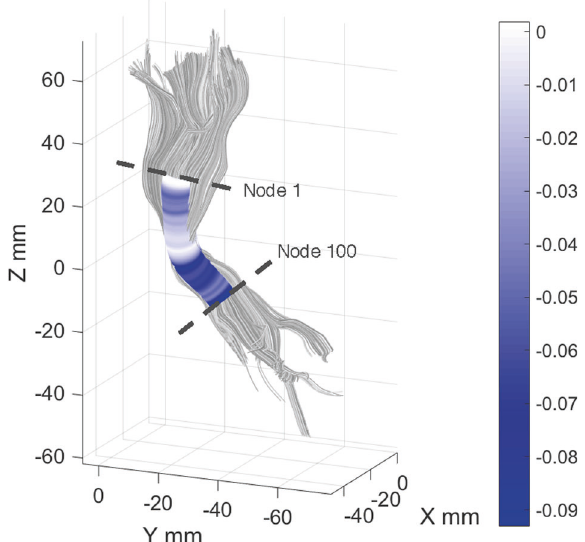
Fig. 5 Correlation of fractional anisotropy (FA) for each segment of the corticospinal tract (gray) with Strengths and Weaknesses Assessment of Normal Behavior Rating Scale for ADHD Hyper- activity Score (SWAN-HY) on clipped regions of interest (blue shaded tube). FA values are regressed out for age, sex, IQ, acquisition site and in-scanner head motion. Strongest correlations were observed at caudal segments of the tract. Node, equidistant segment on tract between clipped regions of